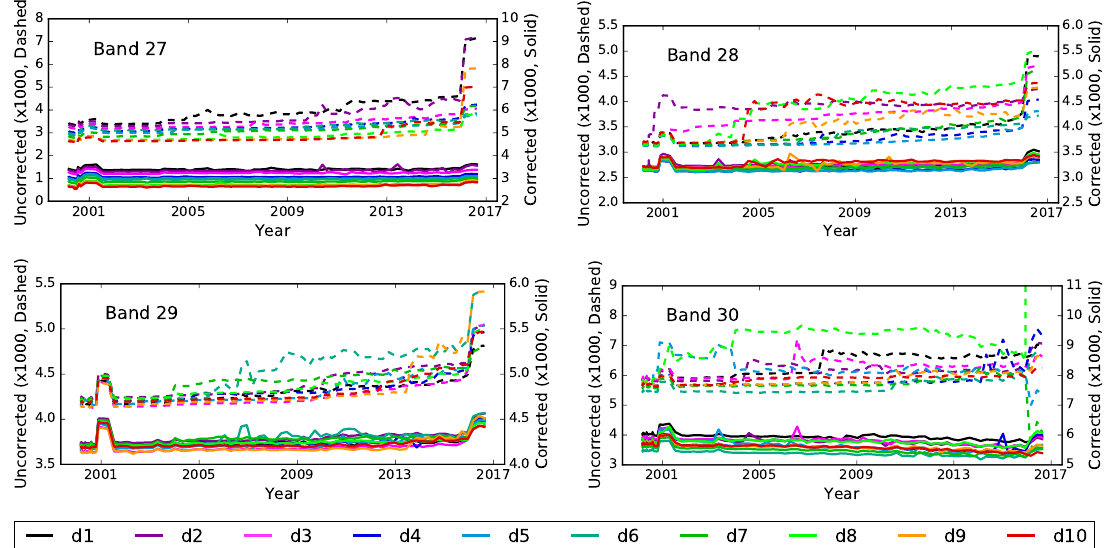
Figure 6. Plots of the linear gain coefficient, b 1 , before (dashed) and after (solid) application of the crosstalk correction, taken from BB warm-up/cool-down data throughout the Terra MODIS mission. For clarity, separate scales are used for the uncorrected ( left ) and corrected ( right ) data, where the overall scale is shifted, but kept at a fixed range, to allow for comparison between the uncorrected and corrected data while preventing significant overlap in the data. For band 30, the scale is truncated because of the extreme change in the gain coefficient for detector 8 for the uncorrected